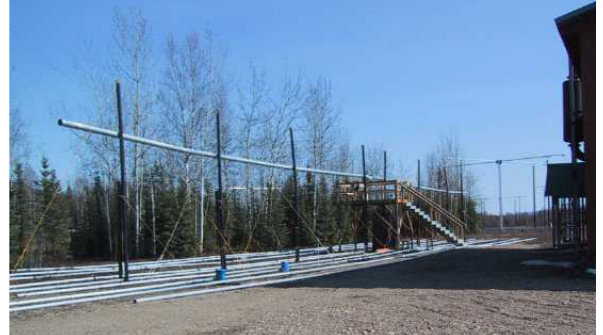
Fig. 1. Photograph (April 2003) of the 2.85-MHz (18-cm diameter – 5200cm long) Hertzian antenna at HIPAS, suspended from in- sulating 10-cm diameter ABS drainpipes, 500cm above a ground plane made up of 6.4-cm diameter aluminum pipes. The antenna has a capacitance of 200pF across its central spark gap. The stair- ways are for central access. One of the antennas of the CW array at HIPAS can be seen in the background. The north side of the Generator Building is on the right side of the